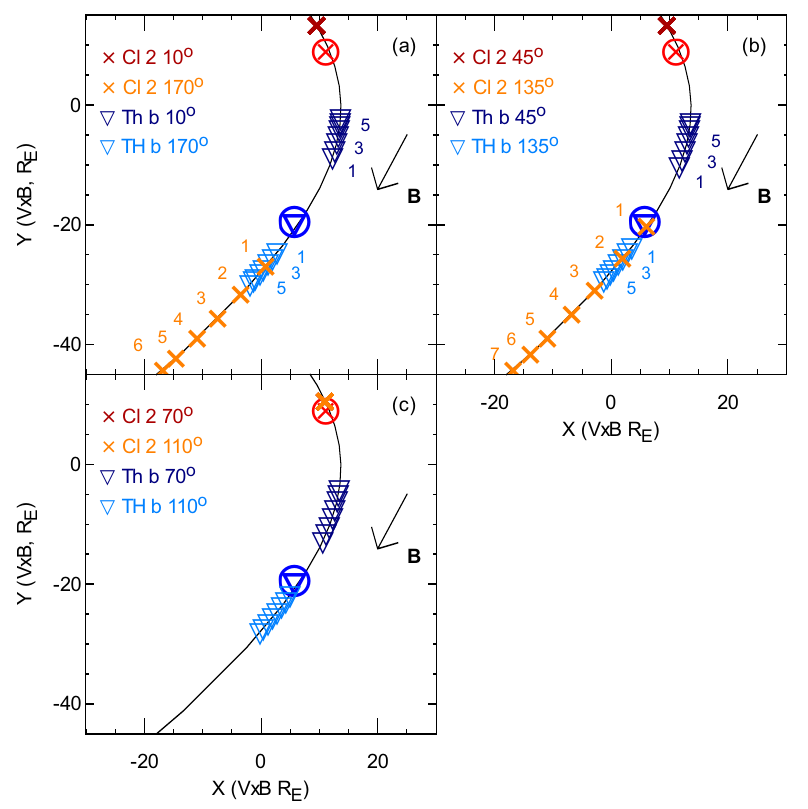
Fig. 4. Points on the bowshock at which electrons cross in order to reach either THEMIS b (encircled triangle) or Cluster (encircled cross). Electrons crossing at triangles travel to THEMIS b, while those crossing at crosses arrive at Cluster 2. The two angles shown are chosen so that all electrons have equal | v k | = v | cos α | . Crossing points are labelled 1 to 8, corresponding to energies 10, 16.7, 27.8, 46.4, 77, 129.2, 215.4 and